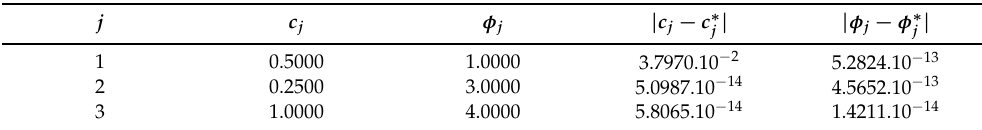
Table 3. Parameters of the function f ( x ) in ( 64 ) and approximate errors using 12 sampling values with h =